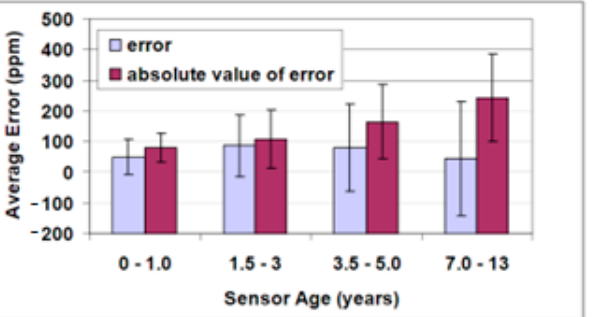
Figure 6. Error from single-concentration calibration checks and multi-concentration calibration challenges at 510 ppm plotted versus sensor age. The error bars represent one standard deviation in the error [91].